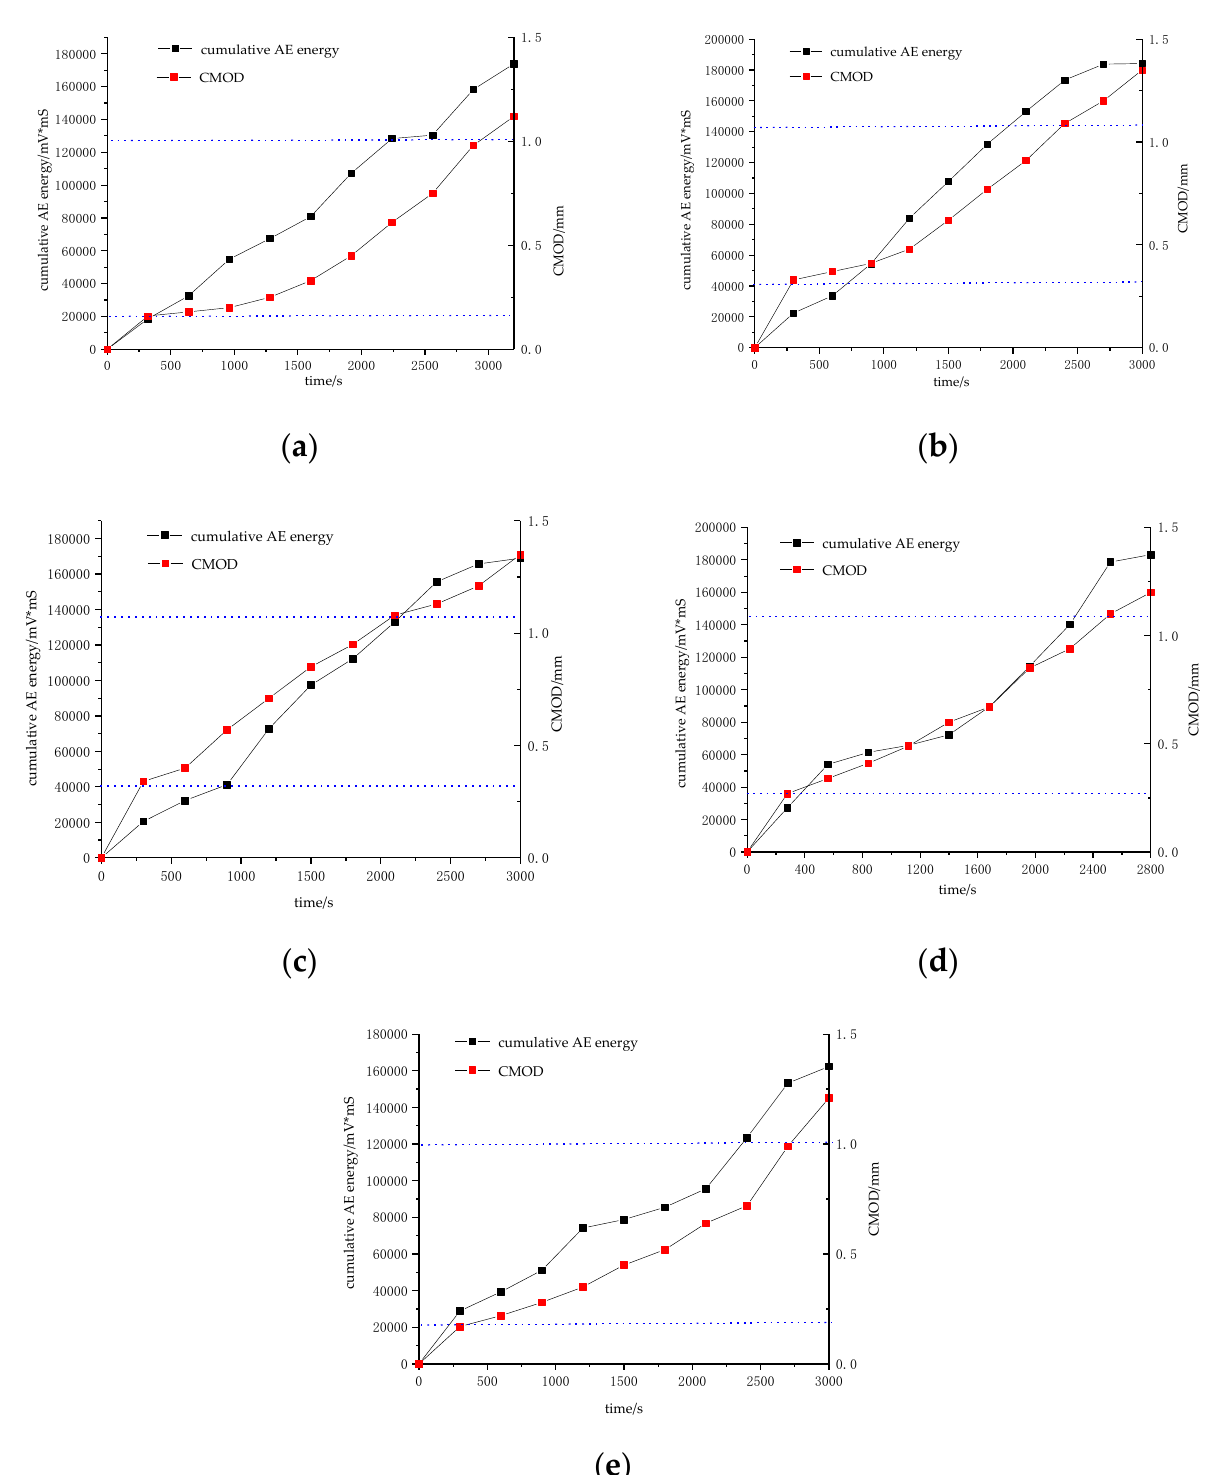
Figure 10. CMOD and cumulative energy change curve: ( a ) Test piece one; ( b ) Test piece two; ( c ) Test piece three; ( d ) Test piece four; ( e ) Test piece five.